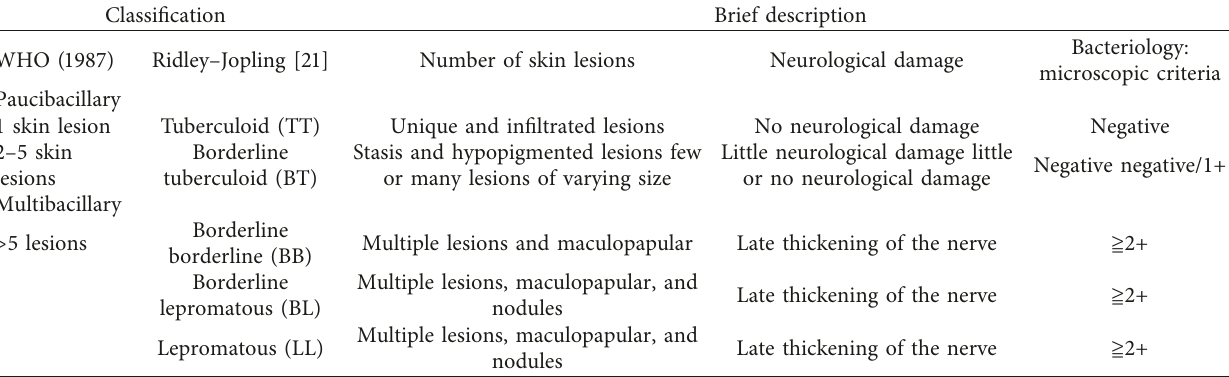
Table 1: Comparison of classifications of leprosy proposed by World Health Organization and Ridley–Jopling.